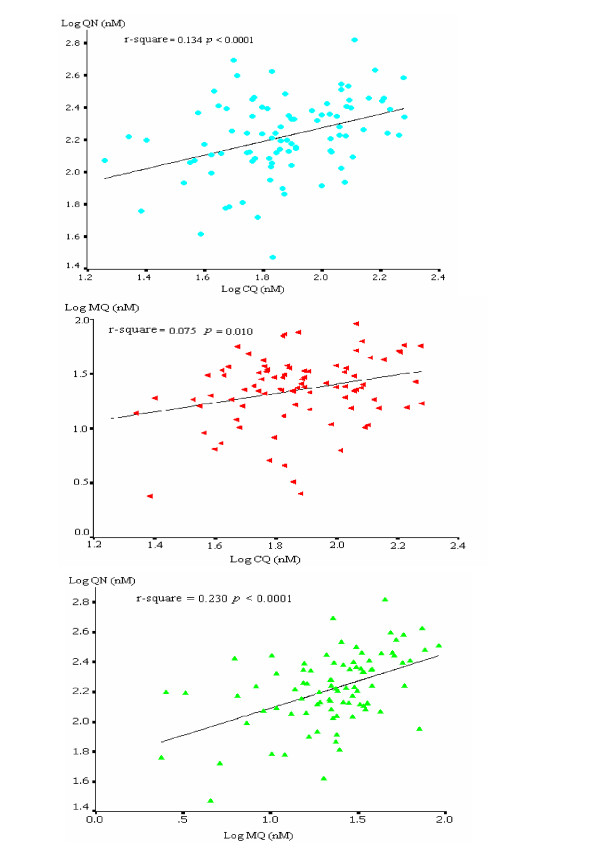
The scatter diagram and the regression line representing the relationship between IC50 (nM) values of CQ, QN and MQ.